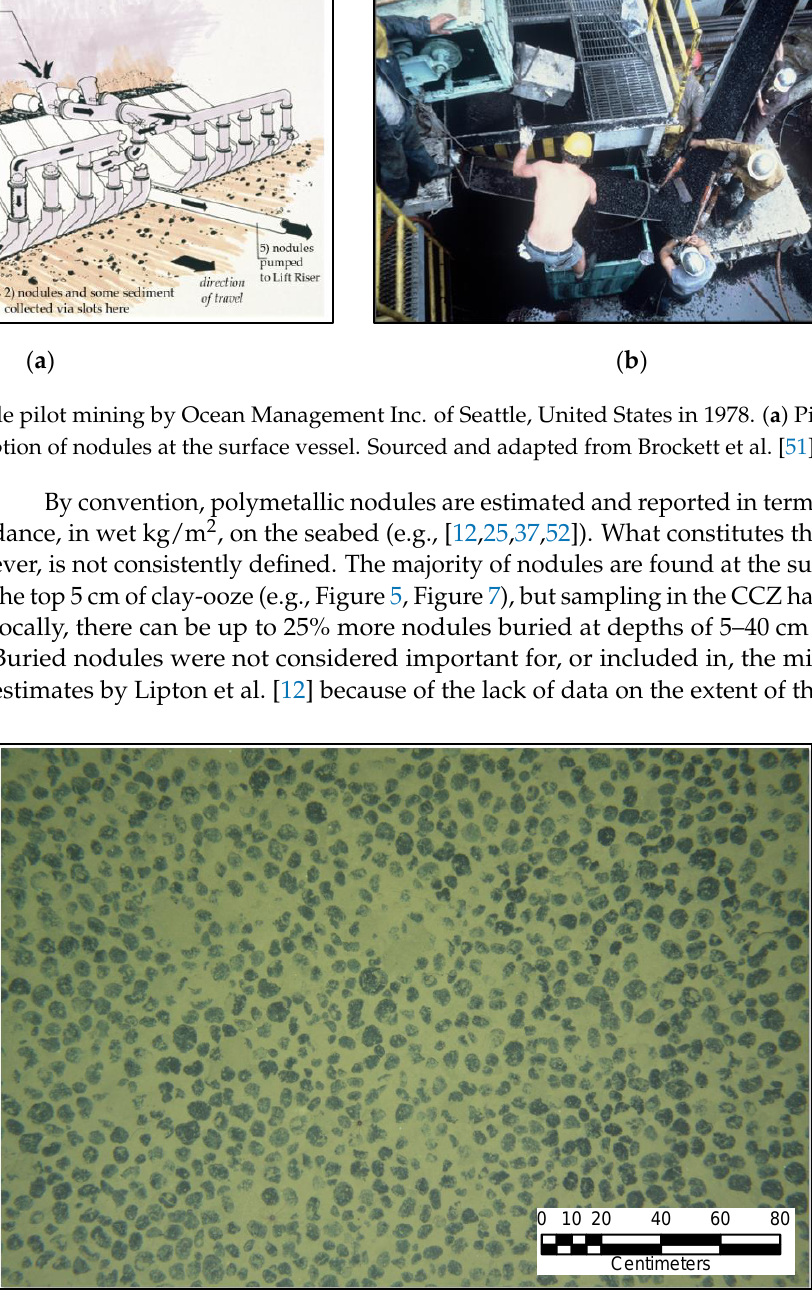
Figure 6. Polymetallic nodule pilot mining by Ocean Management Inc. of Seattle, United States in 1978. ( a ) Pilot nodule collector schematic; ( b ) reception of nodules at the surface vessel. Sourced and adapted from Brockett et al. [51].